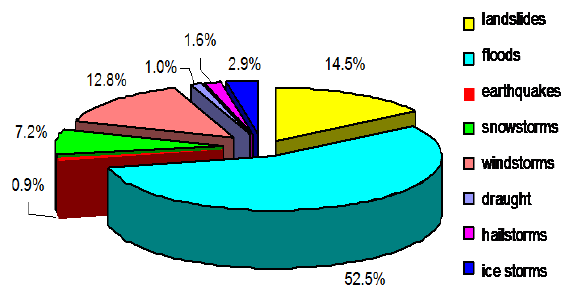
Figure 2. Percentage distribution of different natural disaster that occurred in Bulgaria for the period 2003-2013.